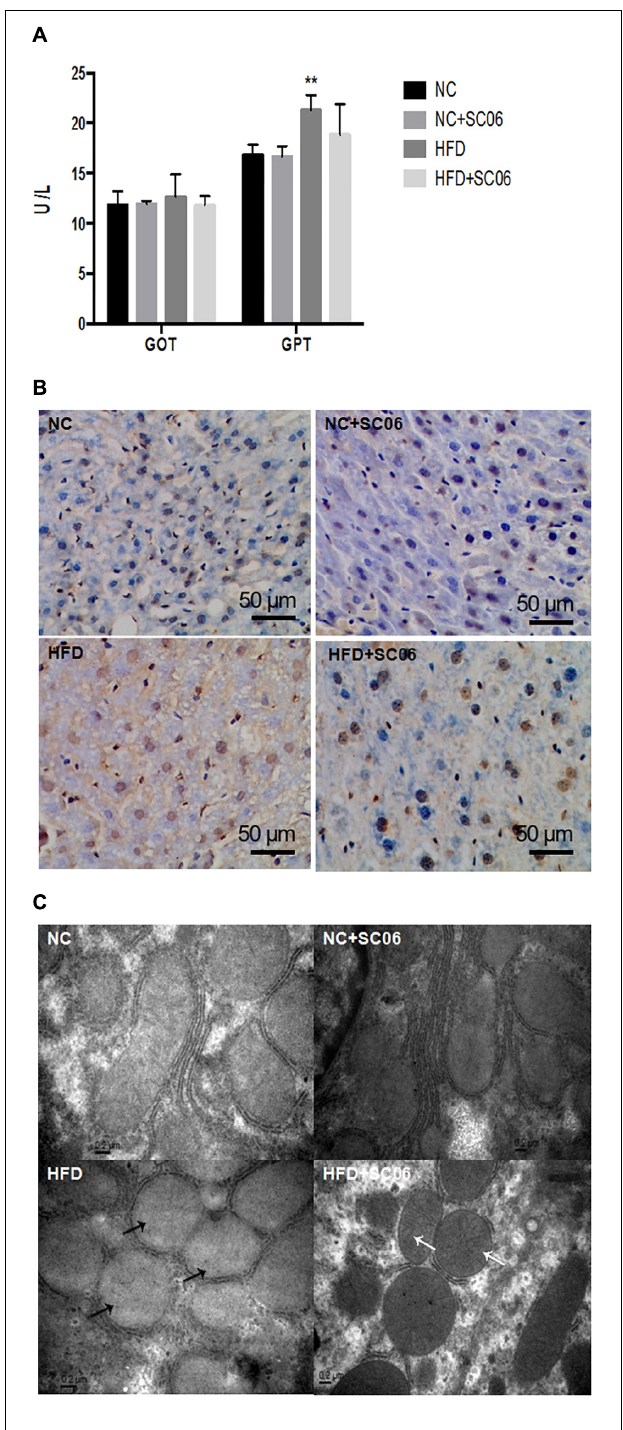
FIGURE 2 | SC06 attenuated liver lesion. (A) GOT and GPT activities, (B) TUNEL sections, (C) electron microscopic sections. The black arrows indicate the abnormal mitochondria, including the disappearance of cristae and swelling. The white arrows indicate the normal mitochondrial. Results are expressed as means ± SD. Differences between groups were determined by one-way ANOVA followed by Tukey’s t -test ( n = 6 for GOT and GPT; n = 4 for TUNEL and TEM). Significant differences between HFD versus ND are indicated as ∗∗ p <